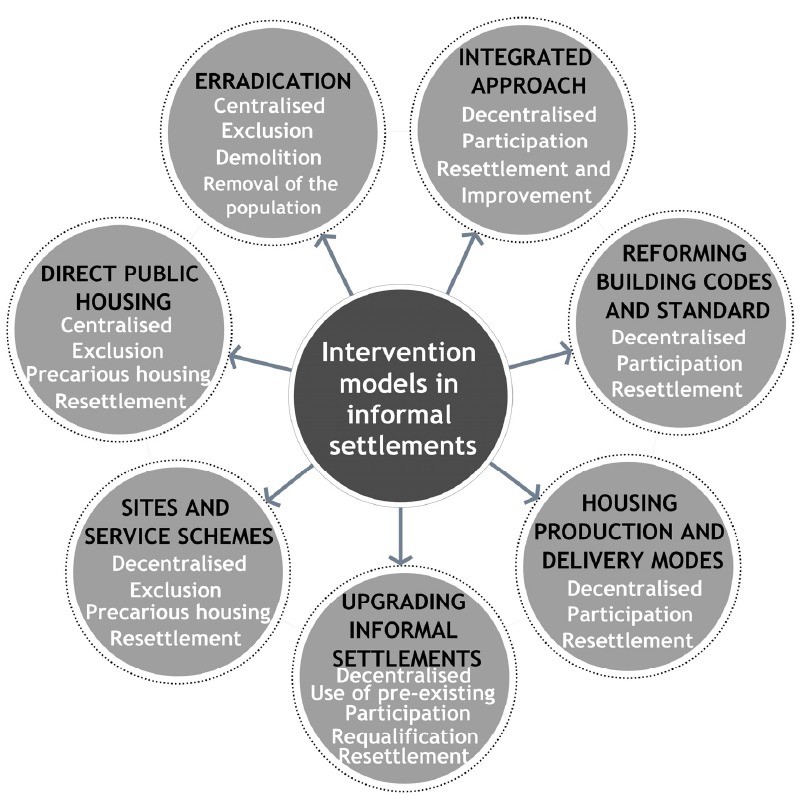
Figure 2. Intervention models in informal settlements (source: prepared by the authors, based on Amado et al. [15]; Cirolia et al. [54]; Keivani and Werna [55]; Wekesa et al.